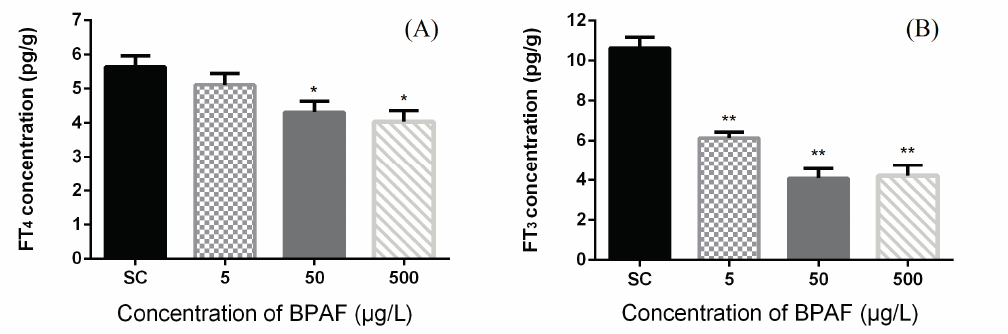
Figure 2. Effects of BPAF on ( A ) free T4 (FT4) hormone concentration and ( B ) Free T3 (FT3) hormone concentration in zebrafish at 168 hpf. The results are presented as mean ± standard error of mean (SEM) (fifty fish as a pool, n = 3). Asterisks indicate statistically significant differences from solvent control (SC: DMSO 0.1%) ( * 0.01 < p < 0.05, ** p <